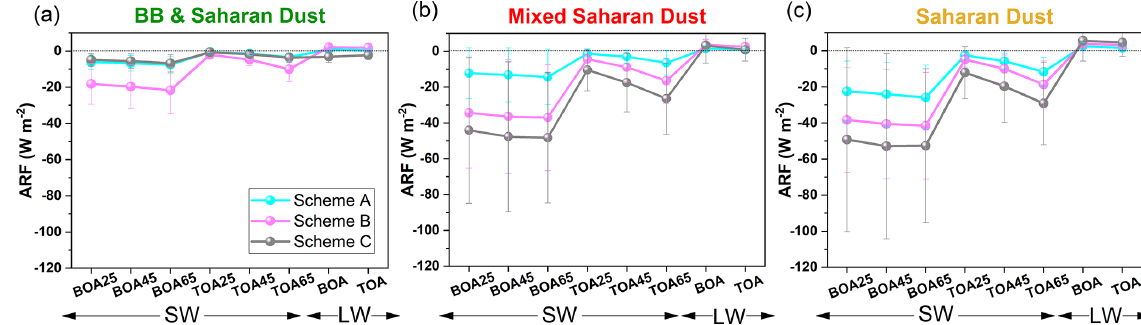
Figure 9. Mean values of SW and LW ARF at BOA and TOA, along with the SD for the three schemes applied regarding the mixing state, namely (a) BB and Saharan dust, (b) mixed Saharan dust and (c) Saharan dust. The dotted line represents the ARF zero value.